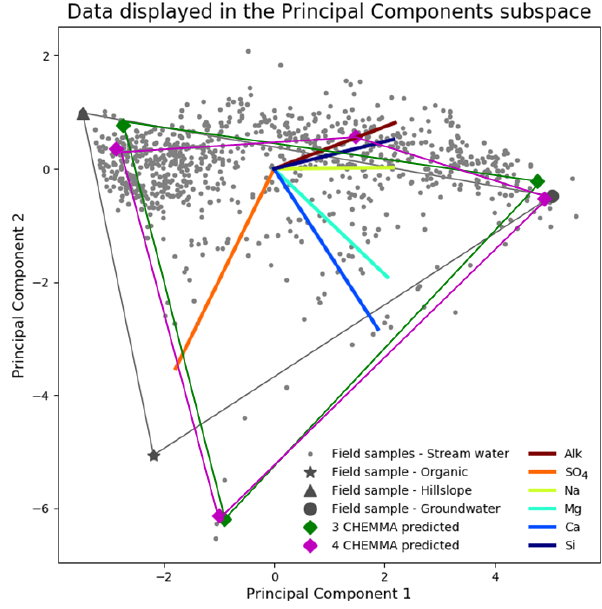
Figure 2. CHEMMA prediction (cluster centroids) for three end- member (blue diamonds) and four end-member (red diamonds) cases plotted in the PC2 vs. PC1 subspace. The colored lines that connect those predicted end-members indicate the convex hull pro- jected into the two-dimensional PC subspace formed by those end- members. The observations (gray dots) inside of the convex hull can be explained as linear combinations of the end-members. The col- ored lines in the center of the plot are the projected original solute axes in this PC subspace. Note that a three-dimensional subspace is required for four